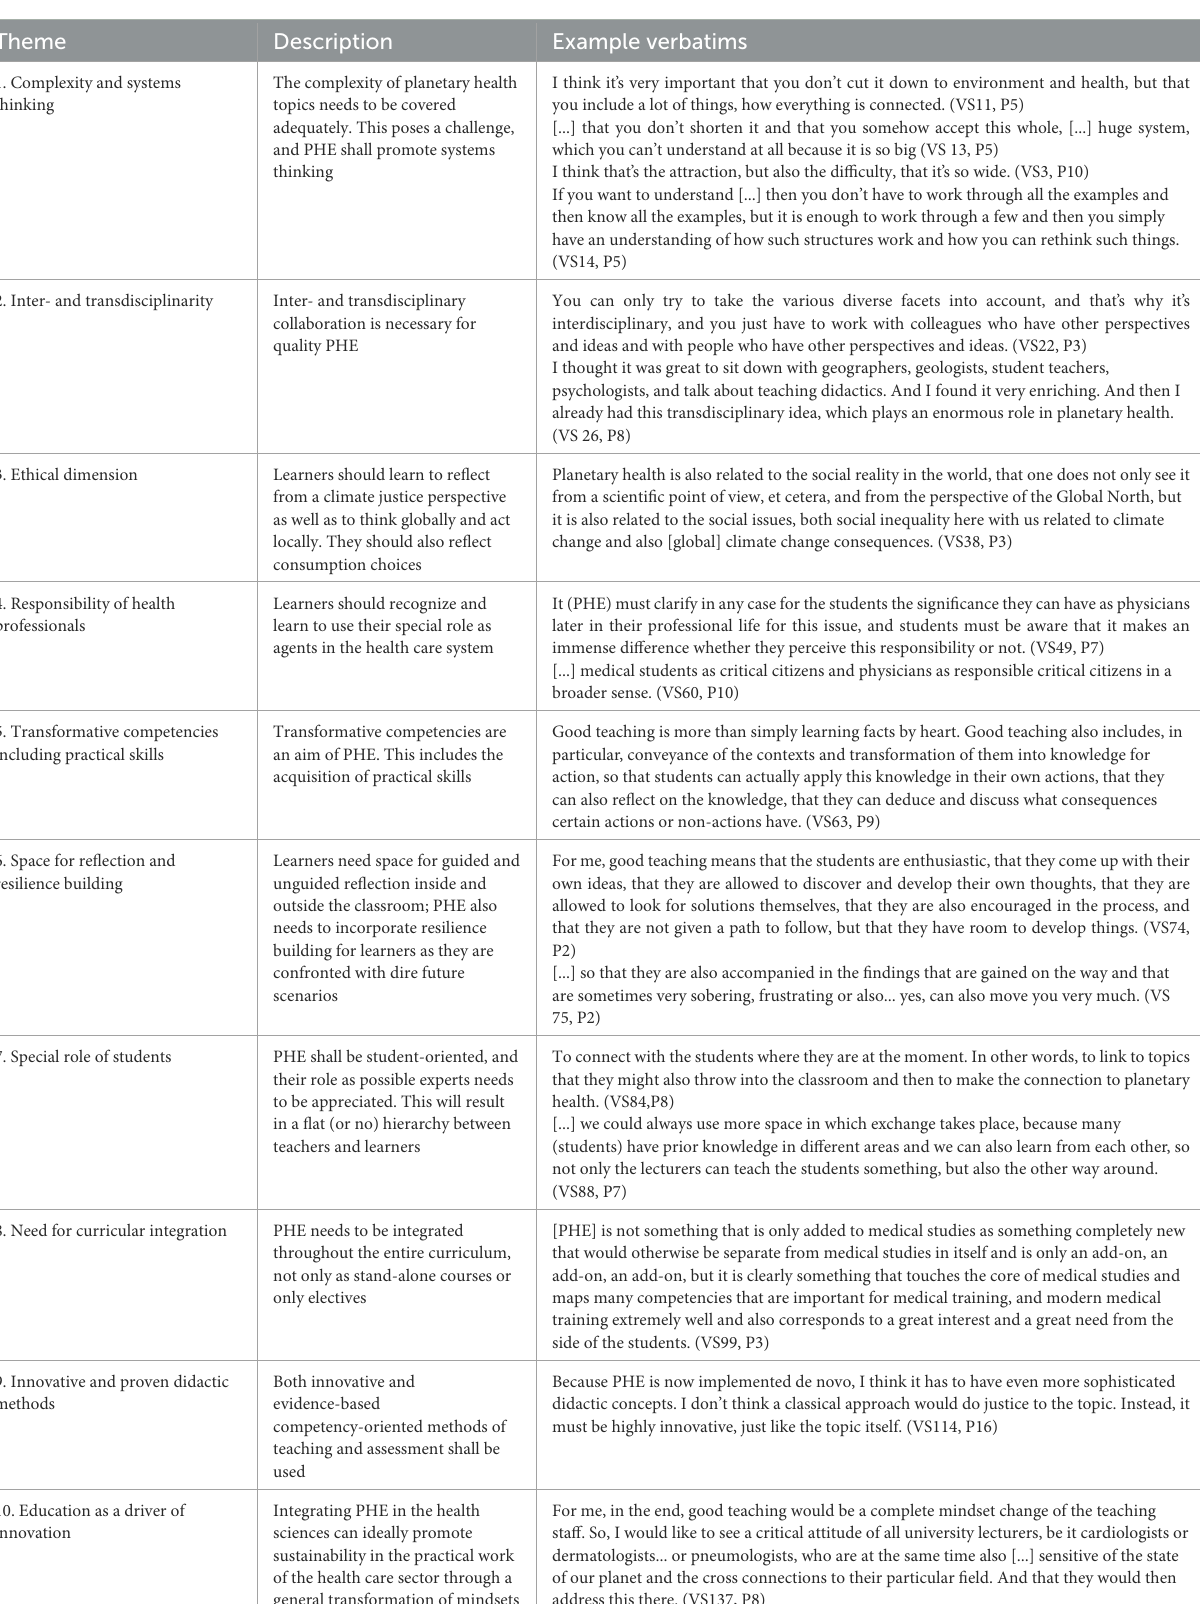
TABLE 3 Ten themes, description of the themes and example